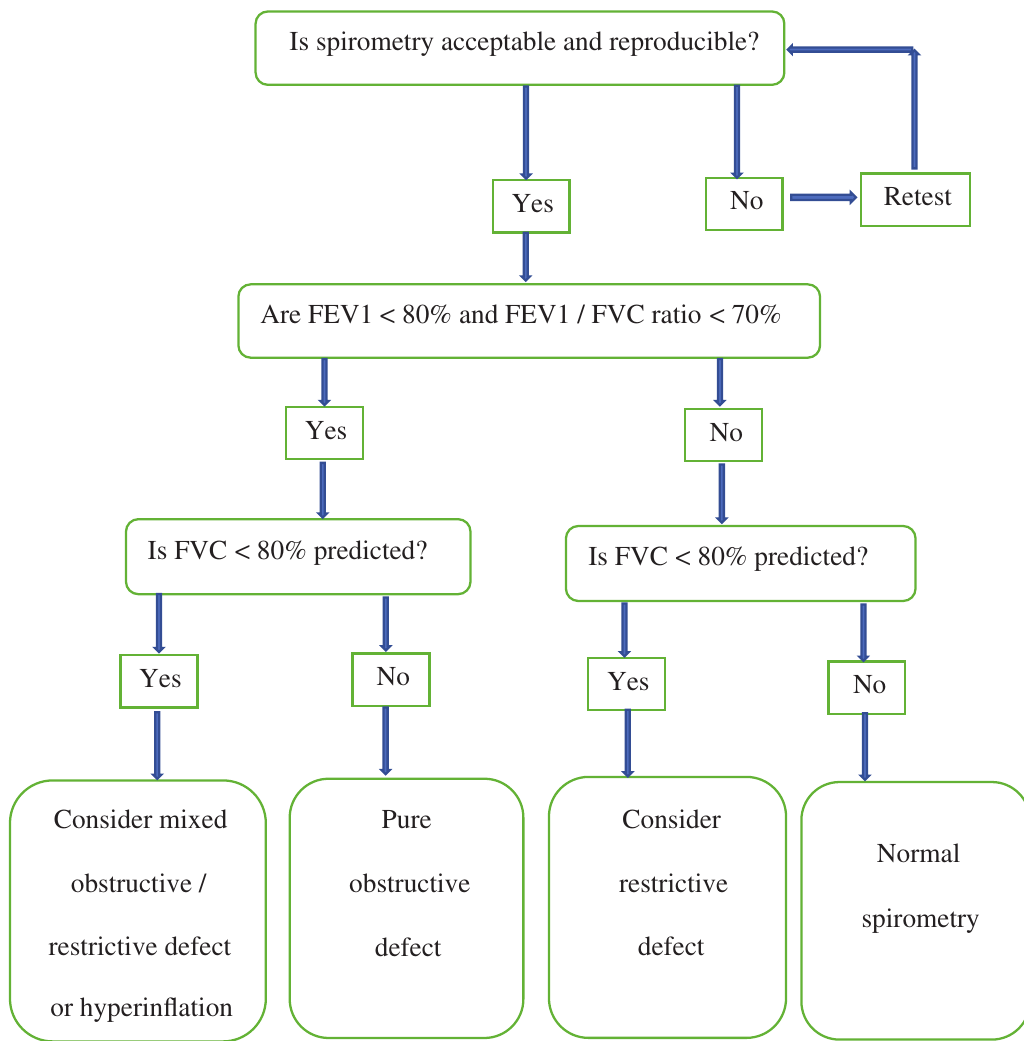
Figure 1. Spirometry diagnostic flow chart – operational definitions of pulmonary